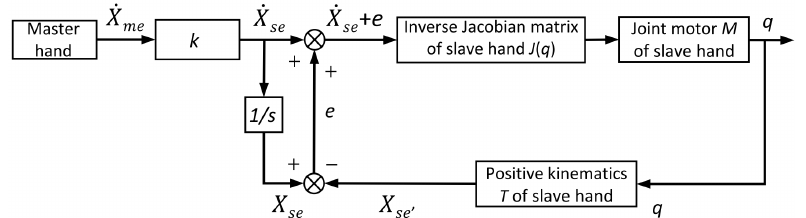
Figure 6. Master–slave control of inverse Jacobian matrix with error compensation.